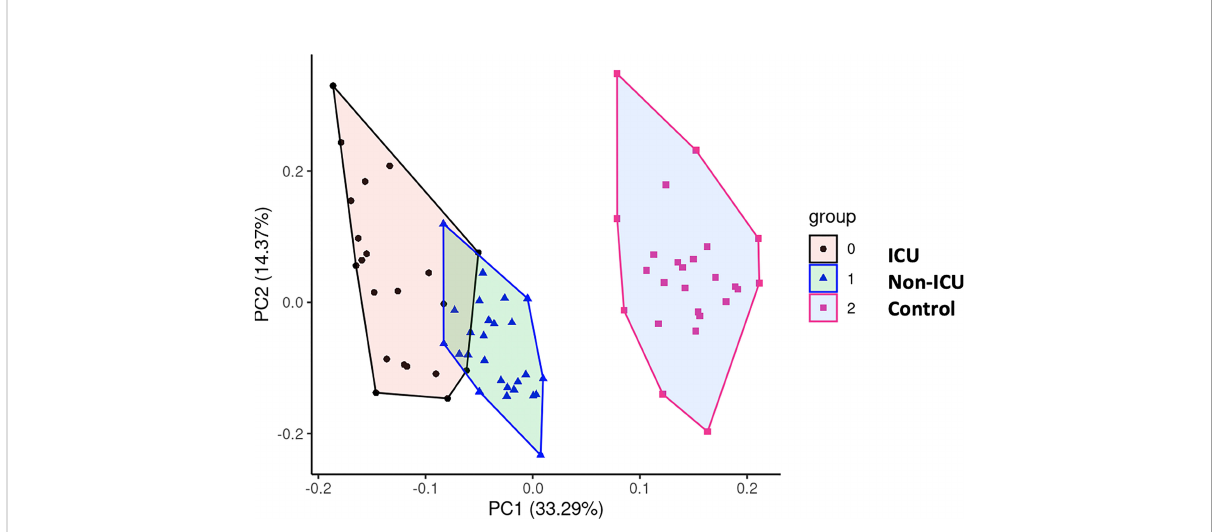
FIGURE 8 Principal Component Analysis (PCA). To test potential associations between the studied parameters,a PCA was computed, showing a clear distinction between COVID-19 patients and uninfected control